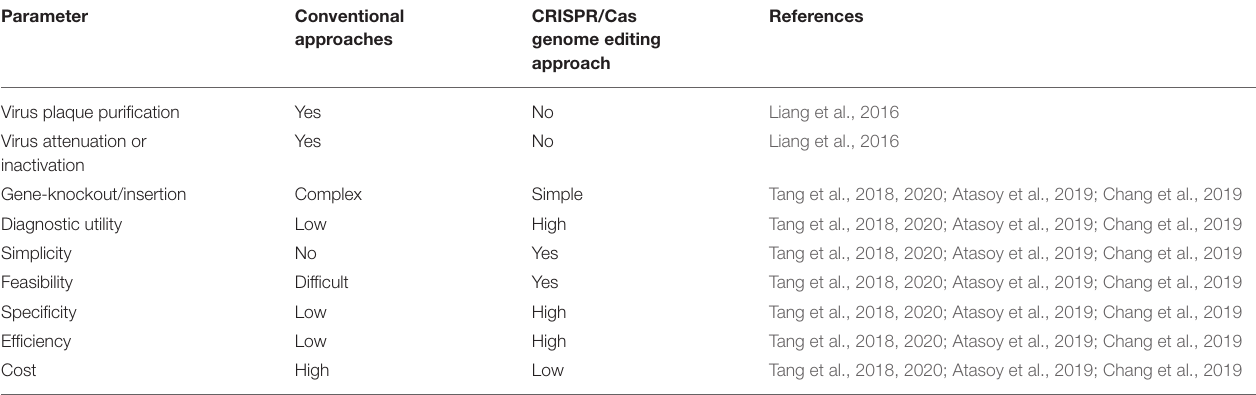
TABLE 1 | Comparison of CRISPR/Cas genome editing approach to conventional avian viral vaccine